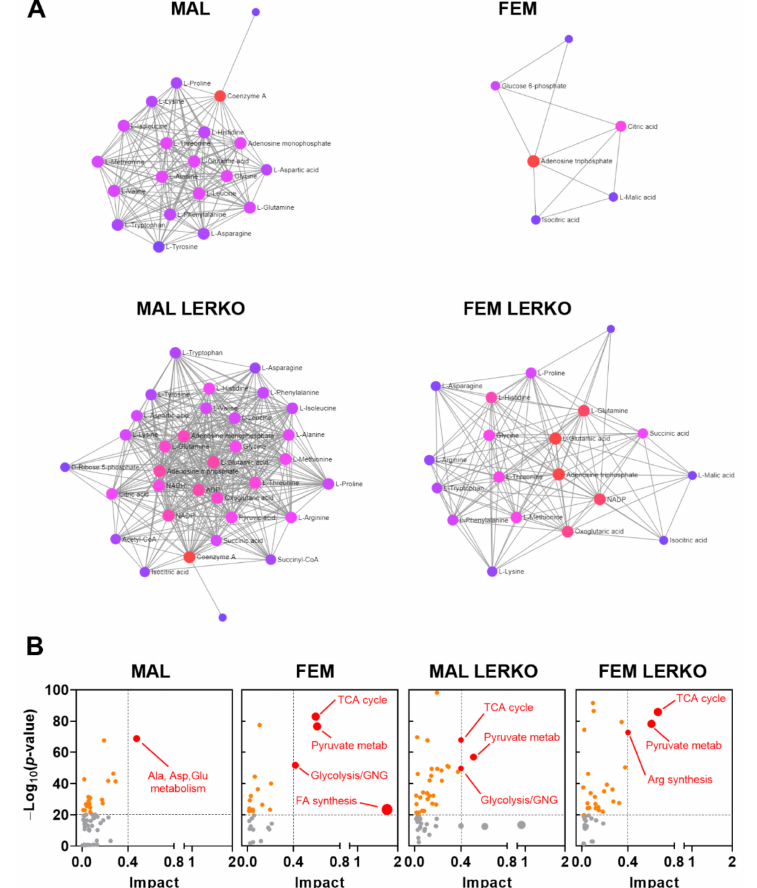
Figure 7. Hepatic ER α contributes to preserve metabolic homeostasis in the liver of females under an excess of dietary lipids. ( A ) HFD effects on metabolite–metabolite interaction in the liver of control males, control females, LERKO males, and LERKO females. ( B ) Metabolic impact analysis of the most relevant biological pathways modified by HFD in the livers of control males, control females, LERKO males, and LERKO females identified through integrative analysis of the changes in the expression of key genes and metabolites. The metabolic pathways are represented as circles according to their enrichment ( p -value, Y axis) and topology analyses (pathway impact, X axis) using MetaboAnalyst 5.0 software. The color of each metabolic pathway is related to the p -value obtained from enrichment analysis and its size represents the fold enrichment score; darker circle colors indicate more significant changes of metabolites in the corresponding pathway. The size of the circle corresponds to the pathway impact score and is correlated with the centrality of the involved